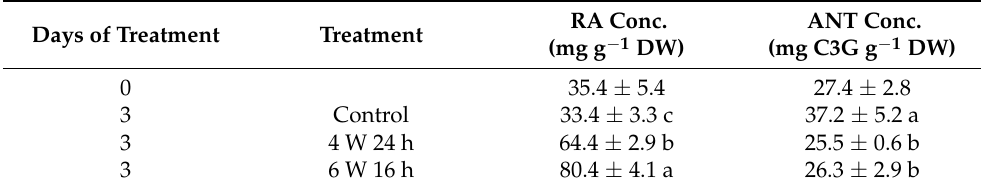
RA Conc. ANT Conc. (mg g − 1 DW) (mg C3G g − 1 DW)